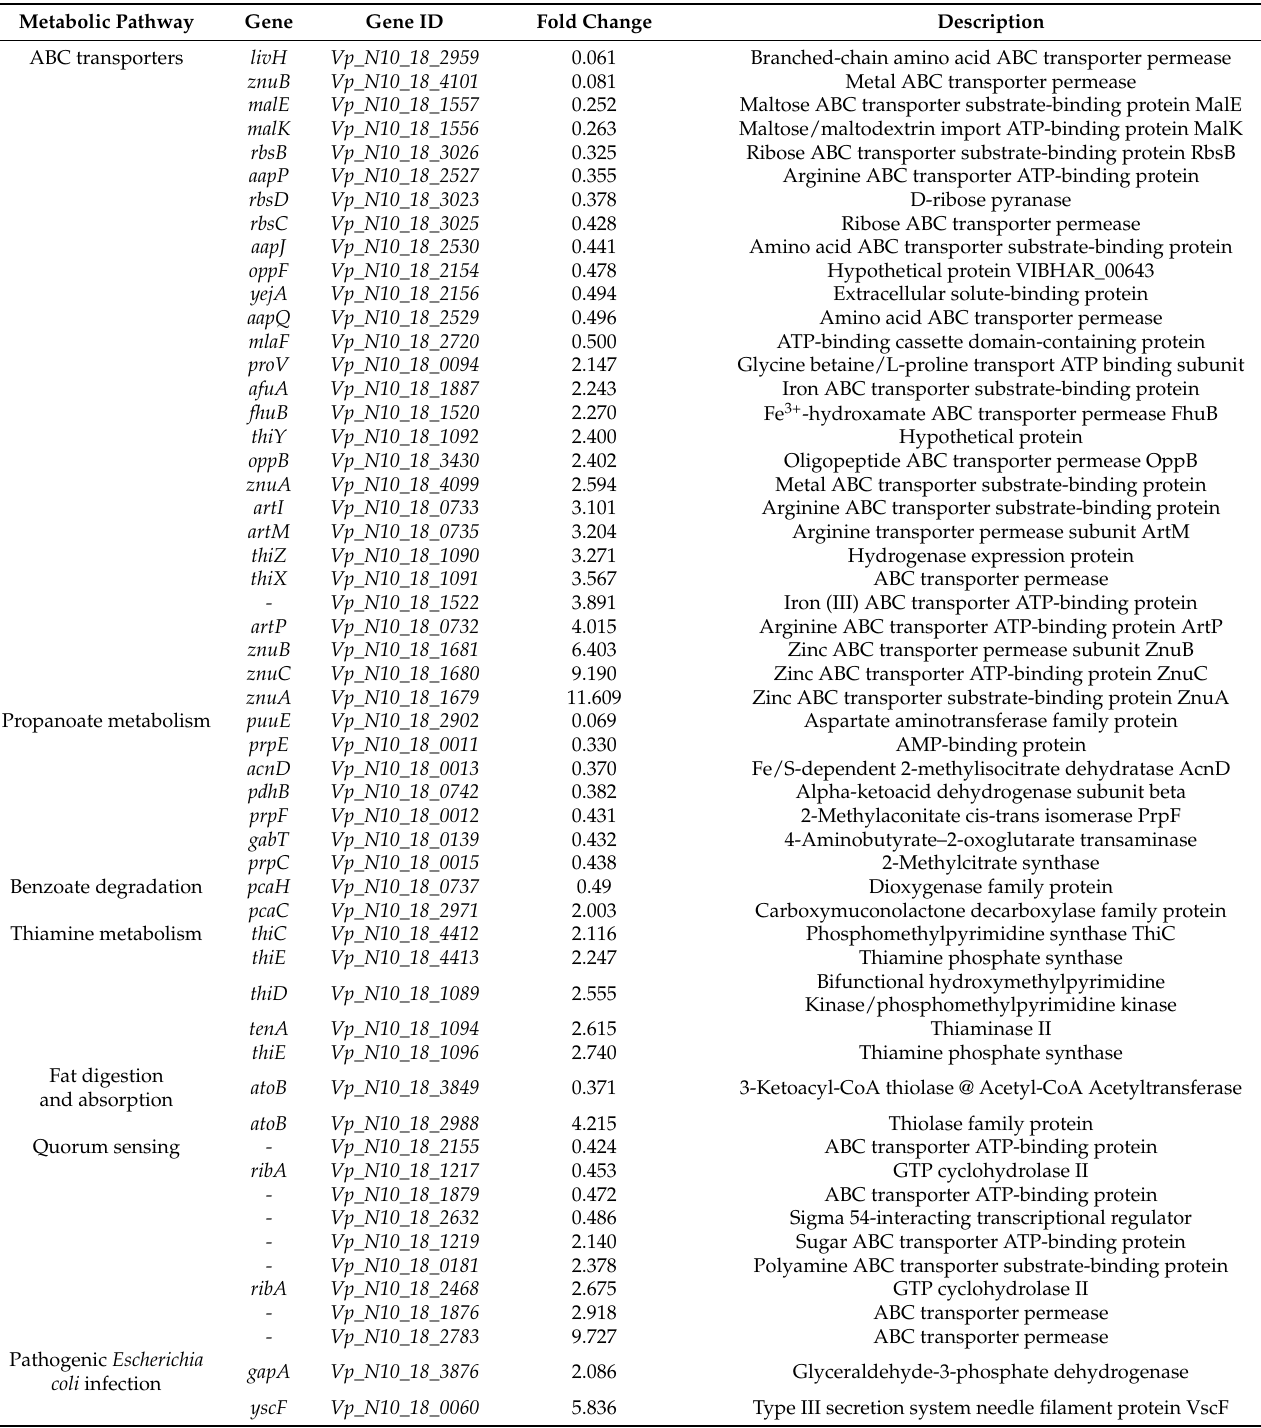
Table 3. The major altered metabolic pathways in V. parahaemolyticus N10-18 under the Cd 2+ (50 µ g/mL)